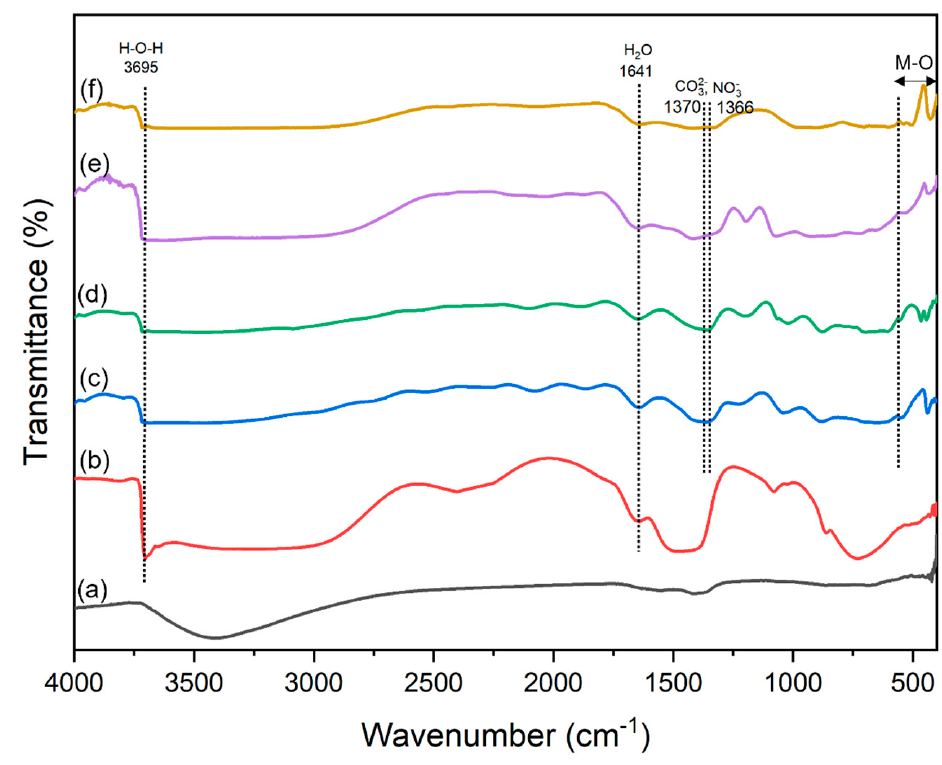
Figure 4. FT–IR spectrum of ( a ) etched, ( b ) anodized, ( c ) E1024, ( d ) E1124, ( e ) A1024, and ( f ) A1124. XRD patterns of samples are shown in Figure 5. The characteristic peaks of Mg, Mg(OH) 2 , and LDH are marked in the figure according to JCPDS No. 00-035-0821, 00- 007-0239 and 00-014-0191, respectively. Mg(OH) 2 peak at 38.02 ◦ shows the dissolution of Mg for the production of LDH [14]. The obtained peaks for samples were compared with patterns related to Mg 6 Al 2 (CO 3 )(OH) 16 · 4H 2 O. The characteristic diffraction peaks of hydrotalcite at (003) were observed in XRD patterns at around 11 ◦ , however, peaks at (006) could not be seen vividly. According to the literature, the intensity of (006) LDH peak is less than (003) [14,21]. In this case, the (006) peak may be too small to be seen. Samples A1024 and E1024 have more intense peaks in comparison to A1124, which can be due to the thicker porous outer layer LDH for samples at pH = 10. The size of intercalated anions and the stacking direction determine the interlayer spacing. In the reaction for the formation of LDH coating, CO 32 − anions can be supplied by the dissolution of CO 2 gas [14]. Table 4 shows the d-spacing related to the samples. According to Table 4, c parameter (3d(003) = c) is 23.007 A ◦ for A1124 which can be related to the CO 32 − or OH − , while this amount is 24.35 A ◦ and 24.087 A ◦ for A1024 and E1024, respectively, relating to the intercalated NO 3 − [34]. It can be inferred that preparing the sample at pH = 11 not only affects (decreases) the lateral size but also the crystal unit cell. In the study of Wang et al. [35] it was shown that decreasing Mg:Al ratio for synthesizing LDH could increase the basal spacing of LDH. The concentration of Mg can affect the layer charge density and change the configuration of the intercalated anion [35]. Therefore, the lower d-spacing for A1124 can be the result of higher Mg cations concentration at the same Al concentration in LDH solution for all of the samples (explained in more detail in Discussion section) and changes in the charge density of the